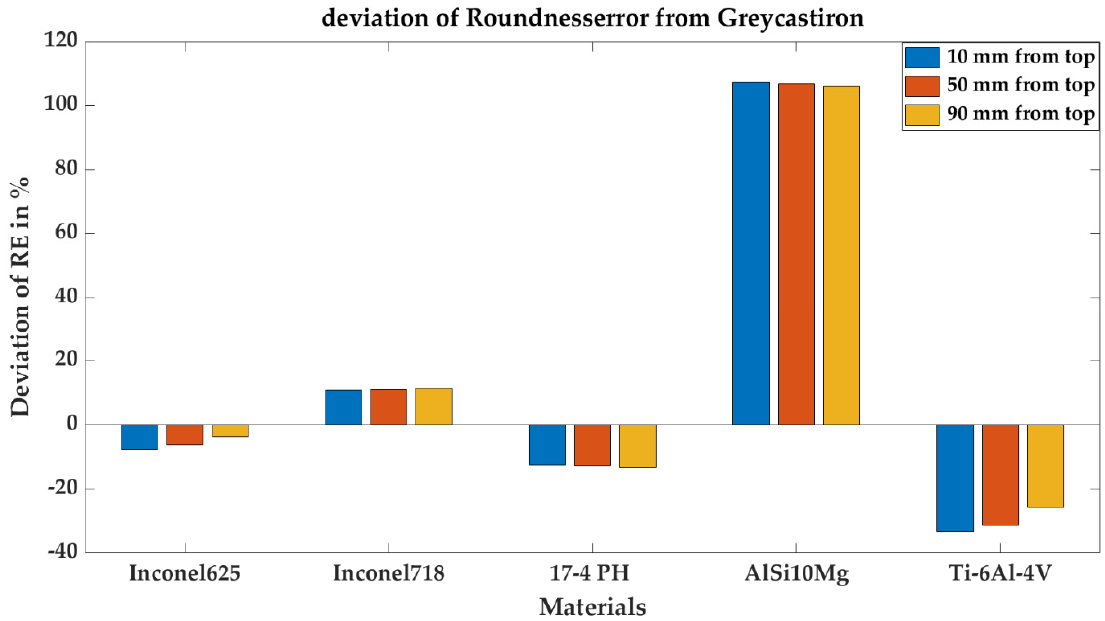
Figure 7. Deviation of roundness error of AM materials from grey cast iron. Materials such as Ti6Al4V and 17-4PH have a significant improvement in roundness compared to grey cast iron. With an approximate roundness error of 39 µ m, Ti6Al4V had the lowest roundness error. The two Inconel materials show different performances. While Inconel 625 had better roundness values than grey cast iron, the roundness error was greater for Inconel 718 than for grey cast iron. AlSi10Mg had about a 120 µ m roundness error, which is very high compared to the grey cast iron. A larger roundness error implies that the piston rings need increased pretension to prevent leakage. This increases the frictional losses to a certain extent [1]; therefore, the friction with AlSi10Mg could increase compared to the grey cast iron. In contrast, friction can be reduced when Ti6Al4V and 17-4PH materials are used.